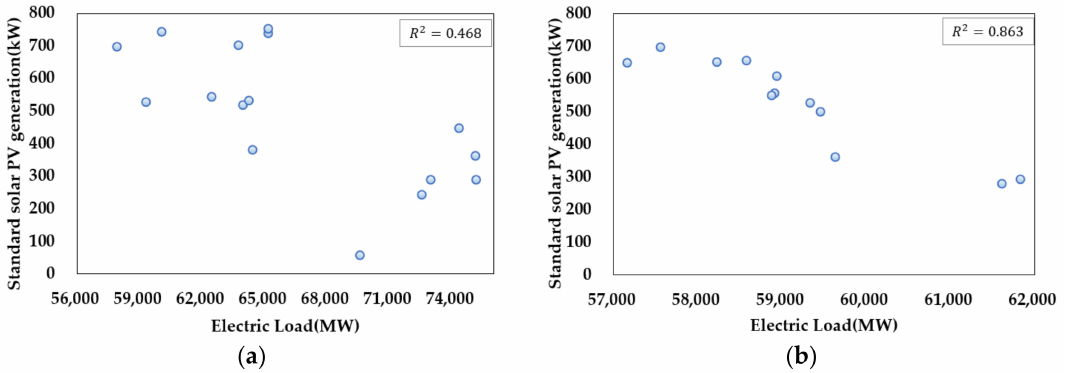
Figure 6. Scatter plot of electric load and standard solar PV generation in the autumn of 2019: ( a ) days filtered by the KMA base temperature range (18–26 ◦ C); ( b ) days filtered by the estimated base temperature range (12–19 ◦